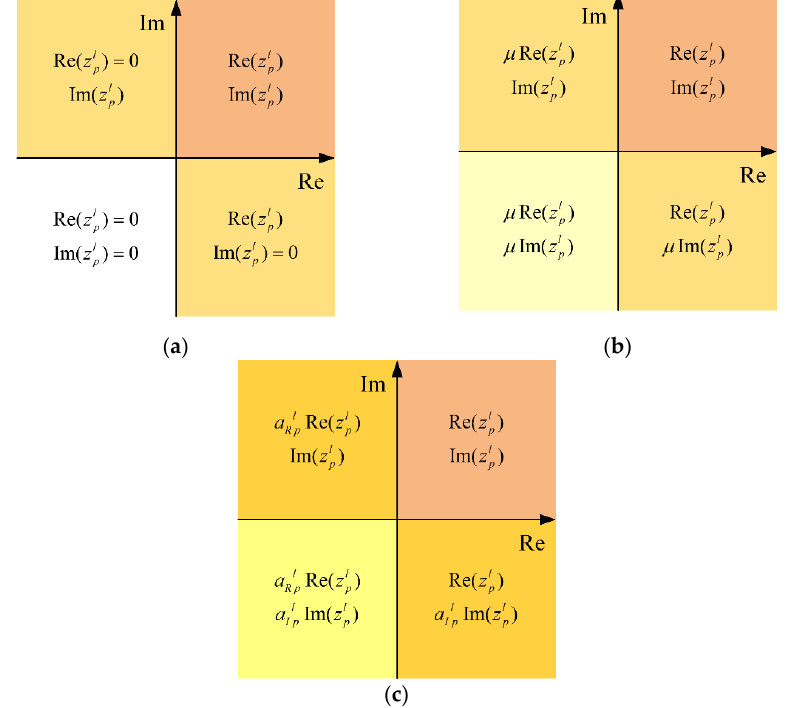
Figure 3. Active regions of different activation functions: ( a ) CReLU; ( b ) CPReLU [31]; ( c ) proposed CPReLU.